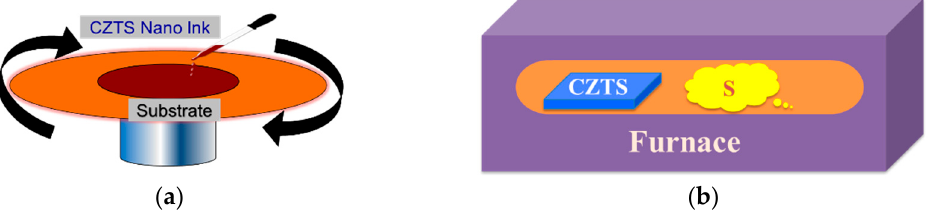
Figure 2. Fabrication process of CZTS films: ( a ) fabrication of CZTS precursor by spin-coating and ( b ) the sulfur vapor annealing process.